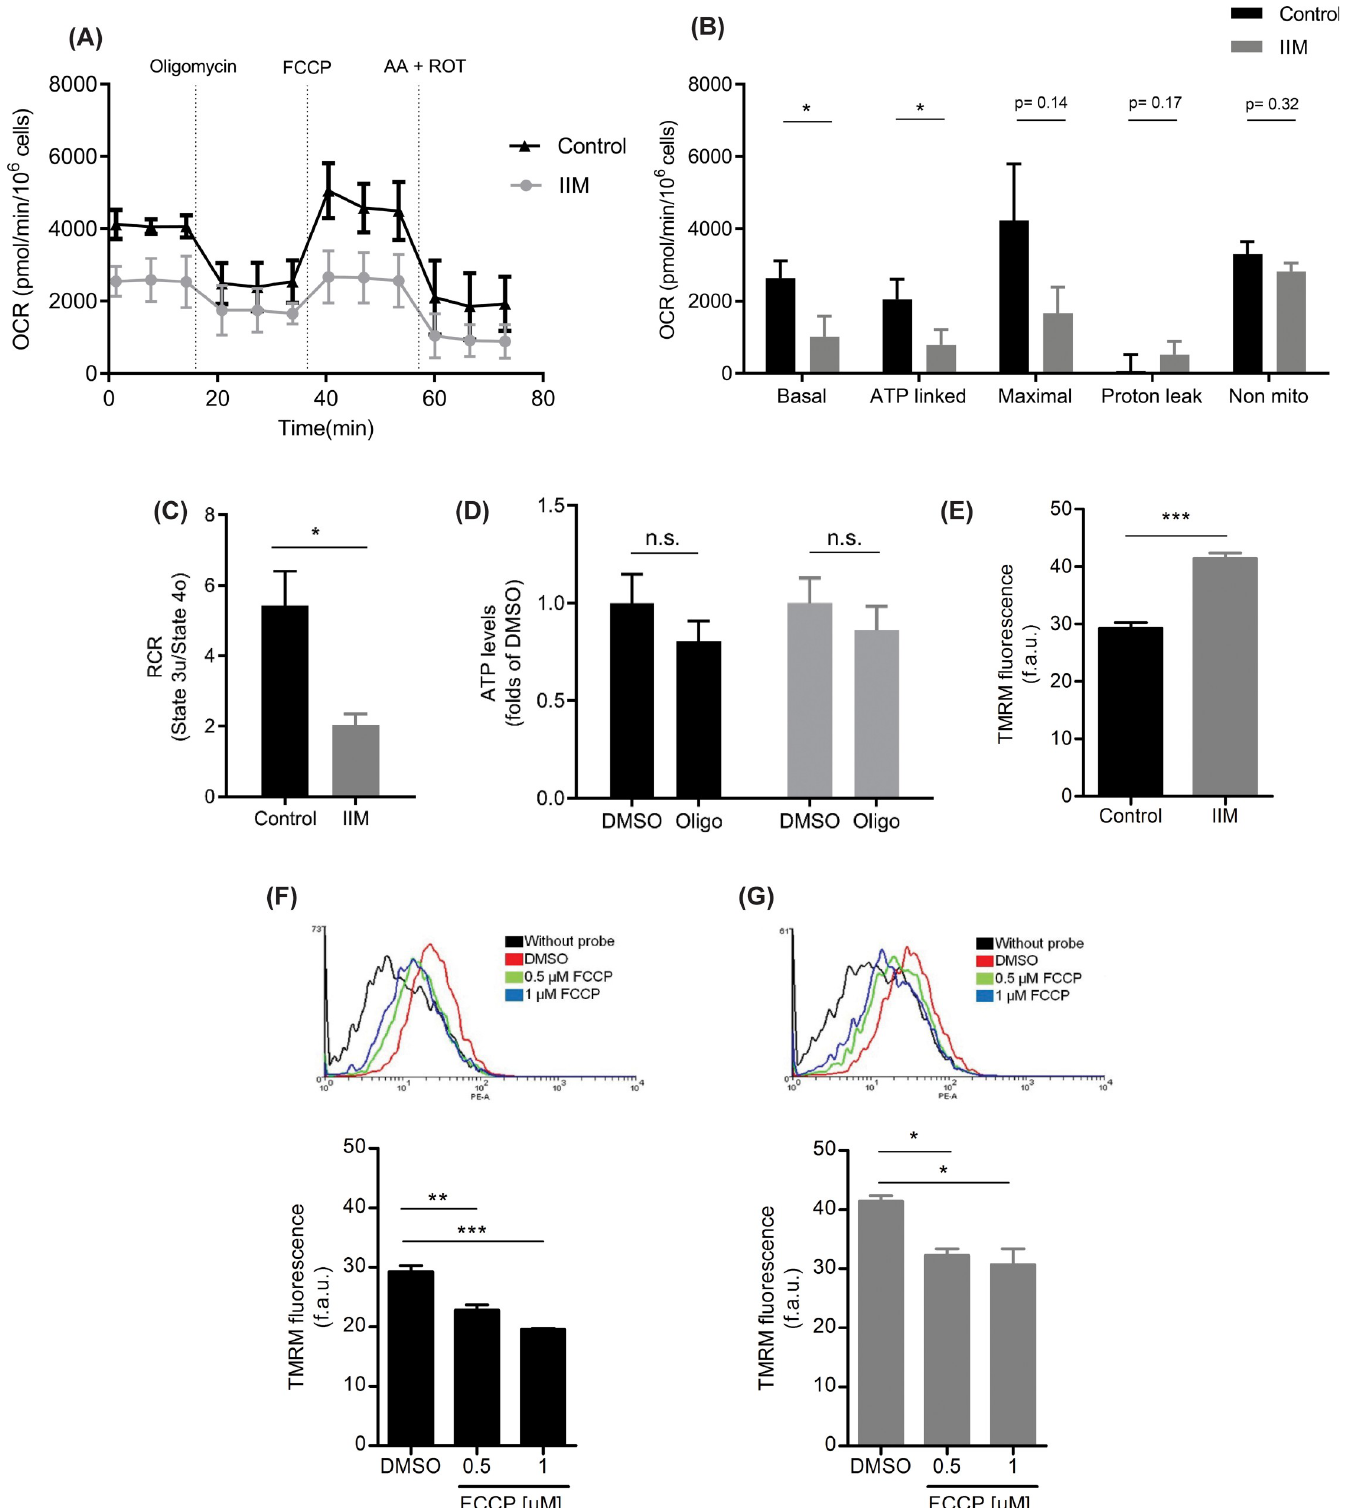
Fig 1. IIM-derived cells show diminished oxygen consumption rate, high mitochondrial membrane potential but similar total ATP levels than control-derived cells. (A) Representative OCR profile plot in control and IIM-derived cells. (B) Oxygen consumption rate (OCR) in control and IIM-derived cells from biopsy